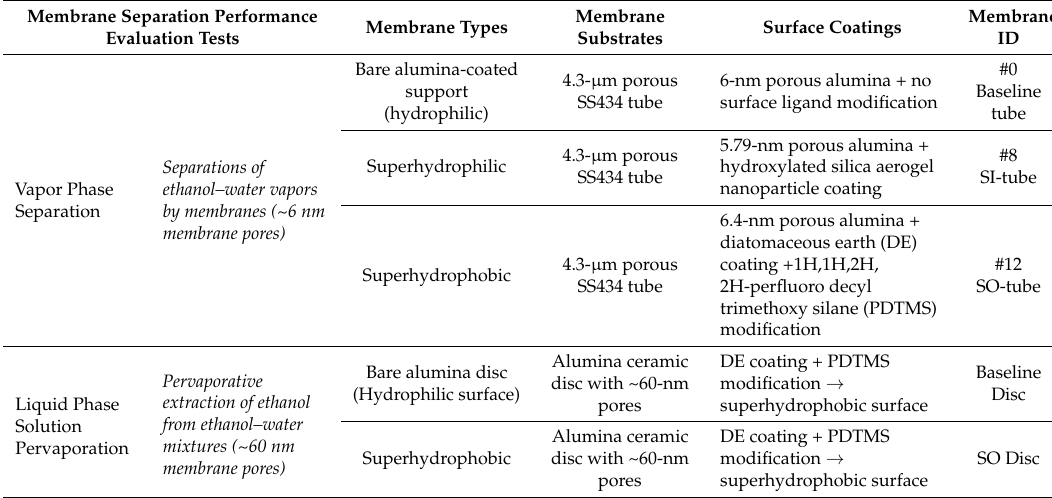
Table 1. Summary description of tested